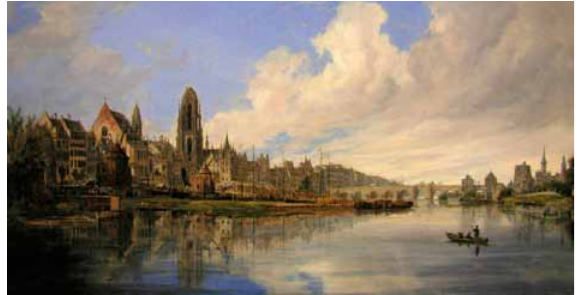
fig. 8. Historical panorama of frankfurt